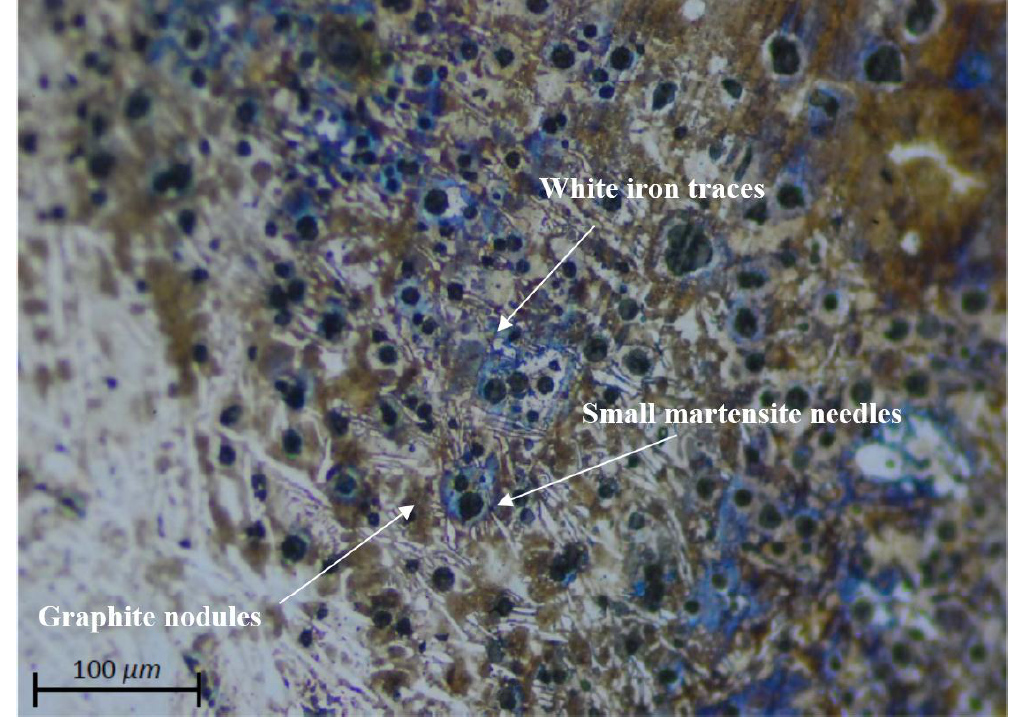
Figure 2. Micrograph of ductile iron weld using 97.6% Ni coated electrode on an Inconel root weld without heat treatment.